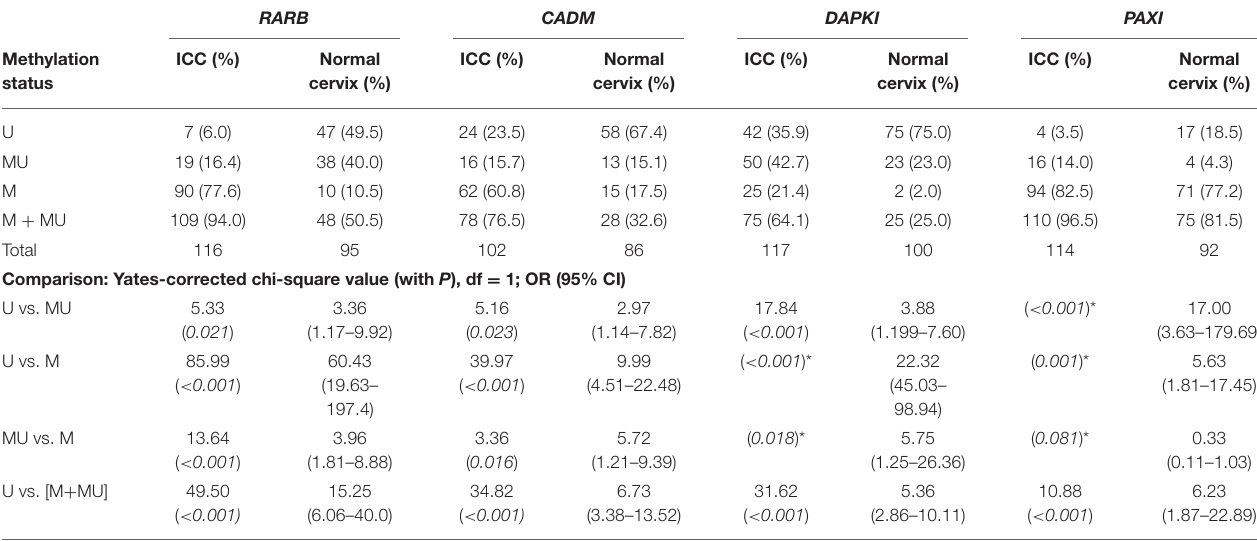
TABLE 2 | Promoter methylation frequency (absolute and relative values) by gene and methylation status, in women with and without invasive cervical